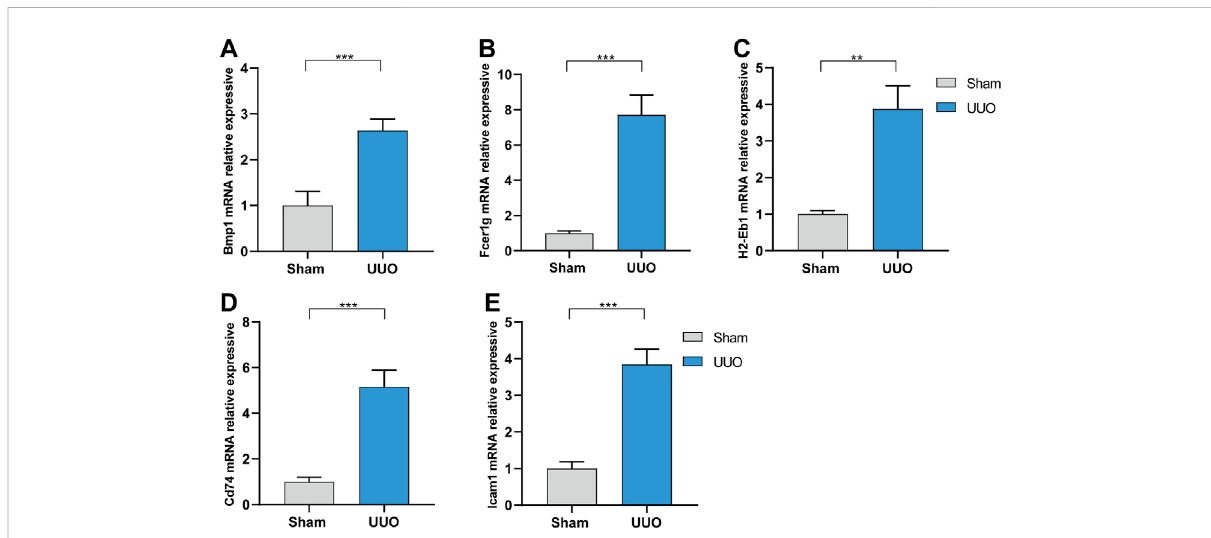
FIGURE 6 The mRNA expression level of the hub genes in vivo analyzed by qRT-PCR in dataset 1. (A) Bmp1. (B) Fcer1g. (C) H2-Eb1. (D) CD74. (E) Icam1. ** p < 0.01, *** p <